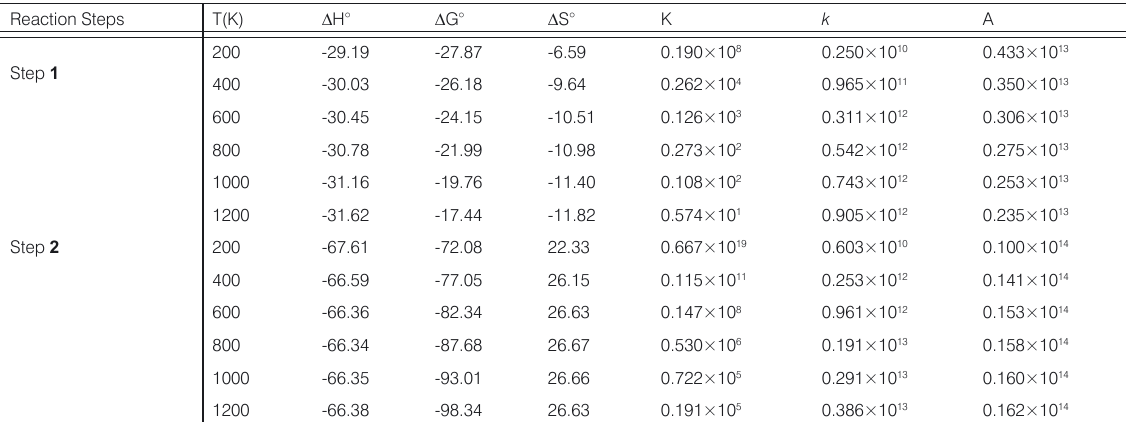
Table 2. The thermodynamic and kinetic data for the involved reaction steps in reaction 1 within the temperature range of 200 -1200 K ( ∆ H°, ∆ G° and ∆ S° are in units KJ mol -1 , KJ mol -1 , J K -1 mol -1 ,